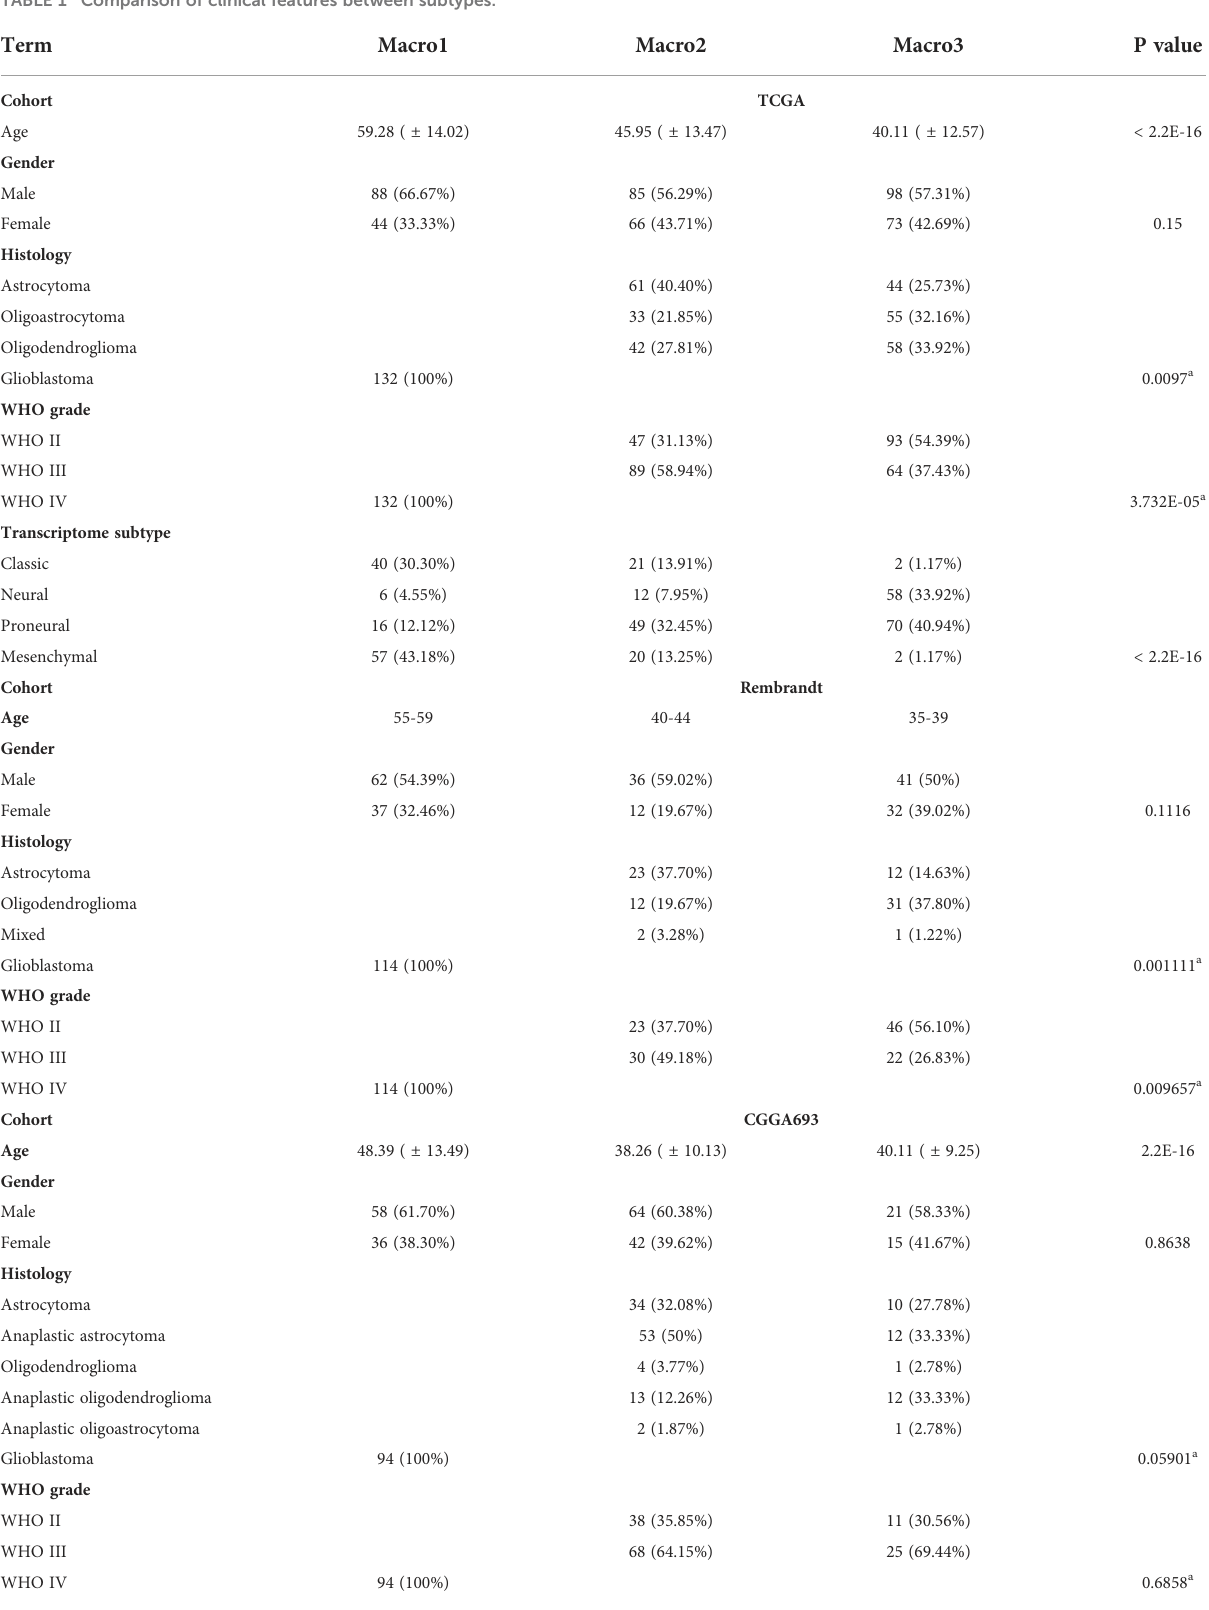
TABLE 1 Comparison of clinical features between